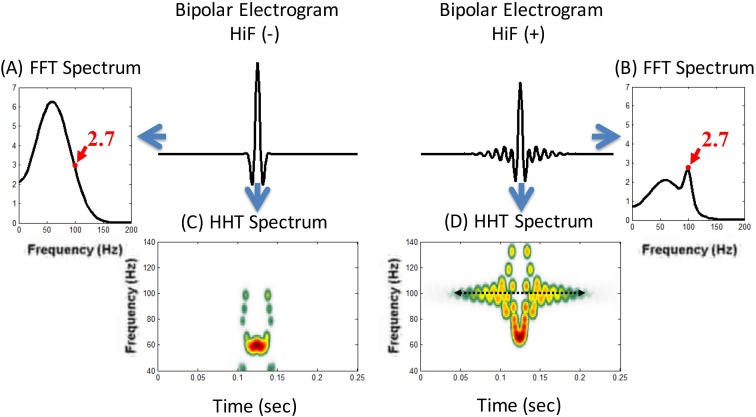
The schematic comparison between the Fourier-based high frequency power spectra (A and B) and HHT spectra (C and D). Ambiguity of the Fourier-based high frequency power spectra between waveform without and with high frequency activity due to a window broadening effect while the corresponding HHT spectra can clearly identify high frequency component (> 70 Hz). FFT: fast Fourier transformation; HiF (-): bipolar electrogram without high frequency activity; HiF (+): bipolar electrogram with high frequency activity.